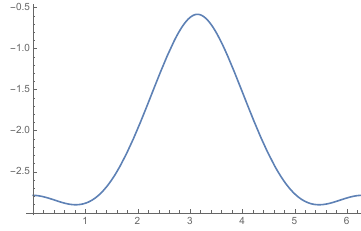
Figure 6 . A cross section of the e(cid:11)ective potential of su (4) with n plot V e(cid:11) ((cid:8) 1 ; (cid:8) 2 ; (cid:8) 3 ) as a function of 0 (cid:20) (cid:8) 1 (cid:20) 2 (cid:25) for constant values of (cid:8) 2 and (cid:8) 3 . The two minima are located at f 5 : 468 ; 3 : 399 ; 2 : 889 g and f 0 : 816 ; 3 : 399 ; 2 : 889 g . We use the simple